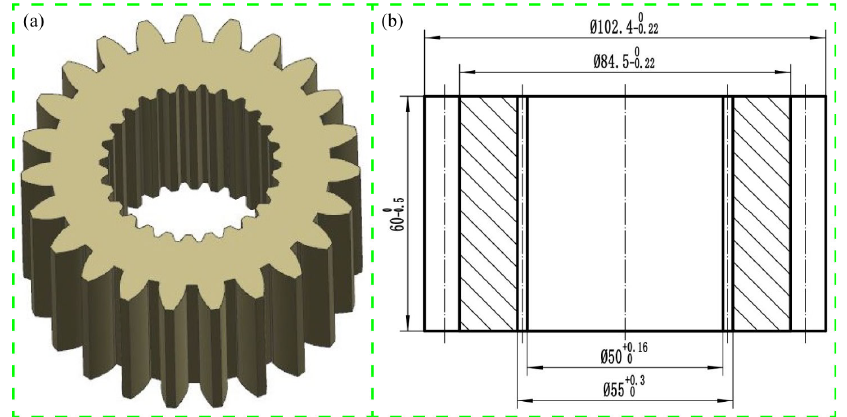
Figure 1. Extrusion drawing of sun gear: ( a ) 3D structure; ( b ) 2D drawing. According to ISO 1328, the important index of internal teeth accuracy is the total M value error ( F M ), and the evaluation index of the outer teeth accuracy is the total profile error ( F α ) and total helix error ( F β ). The dimension accuracy of inner and outer teeth ob ‐ tained by the cold extrusion process was detected using the gear detection center (Model 3906 gear detection center made by Genertec Harbin Measuring & Cutting Tool Co., Ltd., Harbin, China ), as given in Table 1. It can be seen that the tooth accuracy class of profile and lead of the outer teeth were ninth and tenth, respectively, and both were unable to